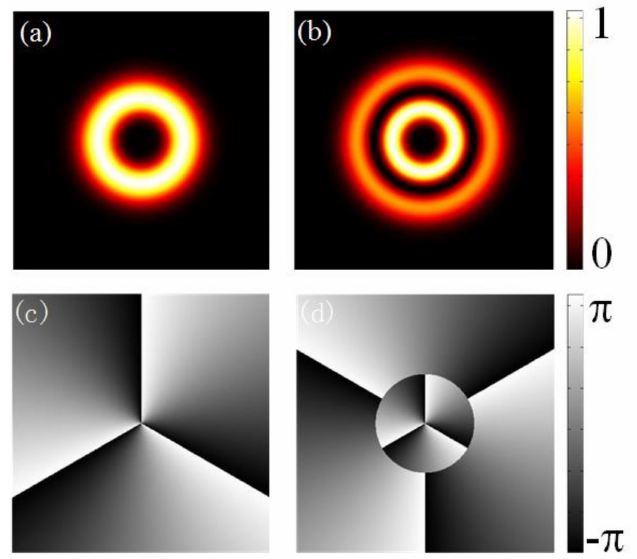
Figure 1. Illustration of Laguerre–Gaussian beams. ( a , b ) Amplitude, ( c , d ) phase distribution of the beams with l = 1, p = 0 ( a , c ) and l = 3, p = 1 ( b , d